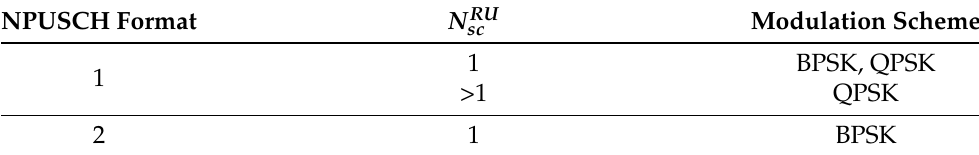
Table 7. NPUSCH modulation schemes [2].